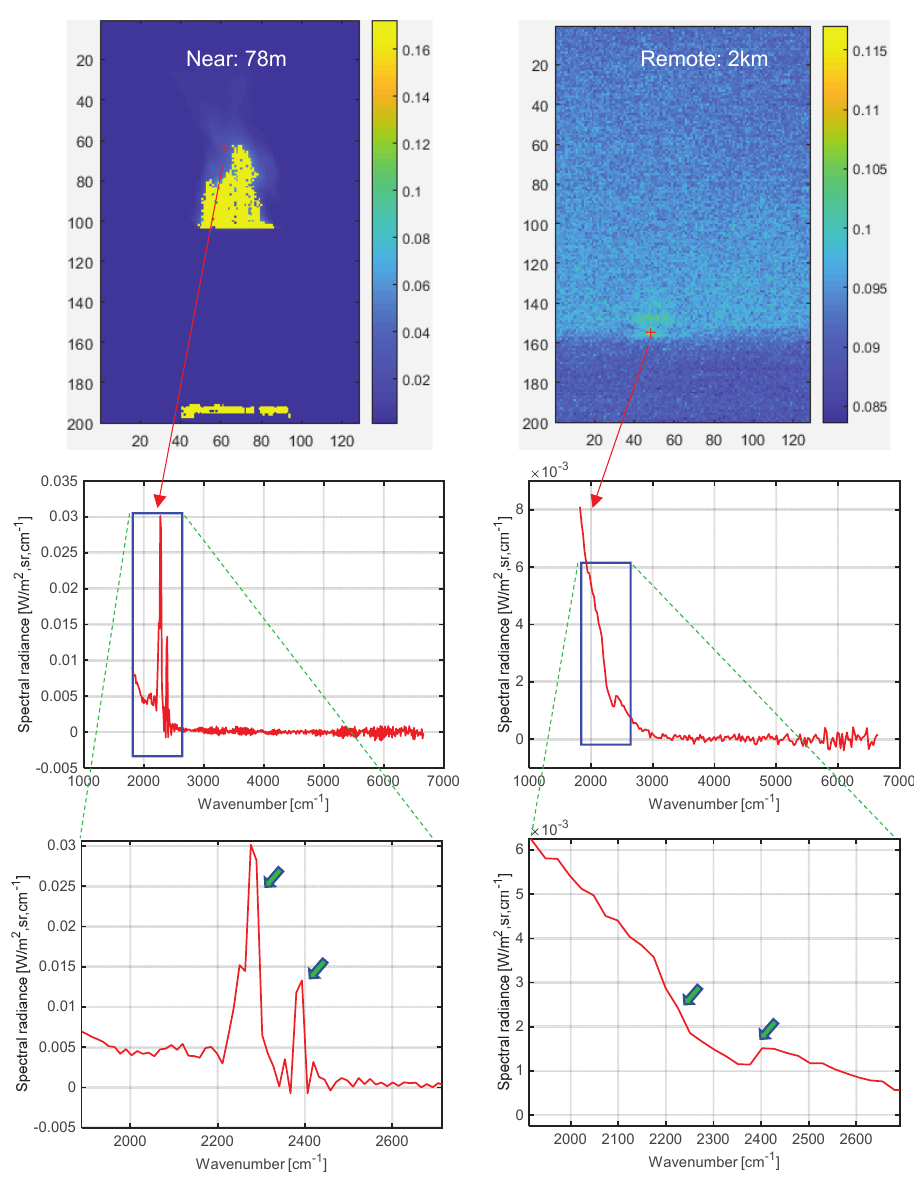
Figure 9. Comparison of CO 2 signatures in terms of distance: (left) near CO 2 (78 m), (right) remote CO 2 (2